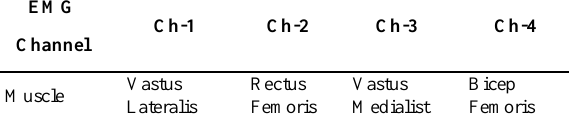
Figure 4. The locations of sEMG electrodes. Table 1 . Muscles for each sEMG channel.